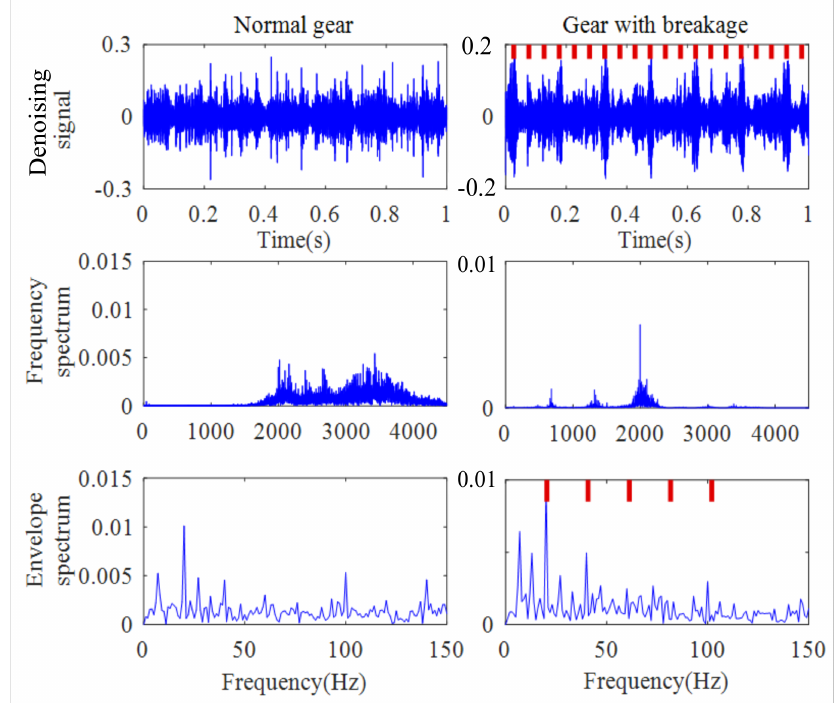
Figure 18. Denoising results based on the proposed